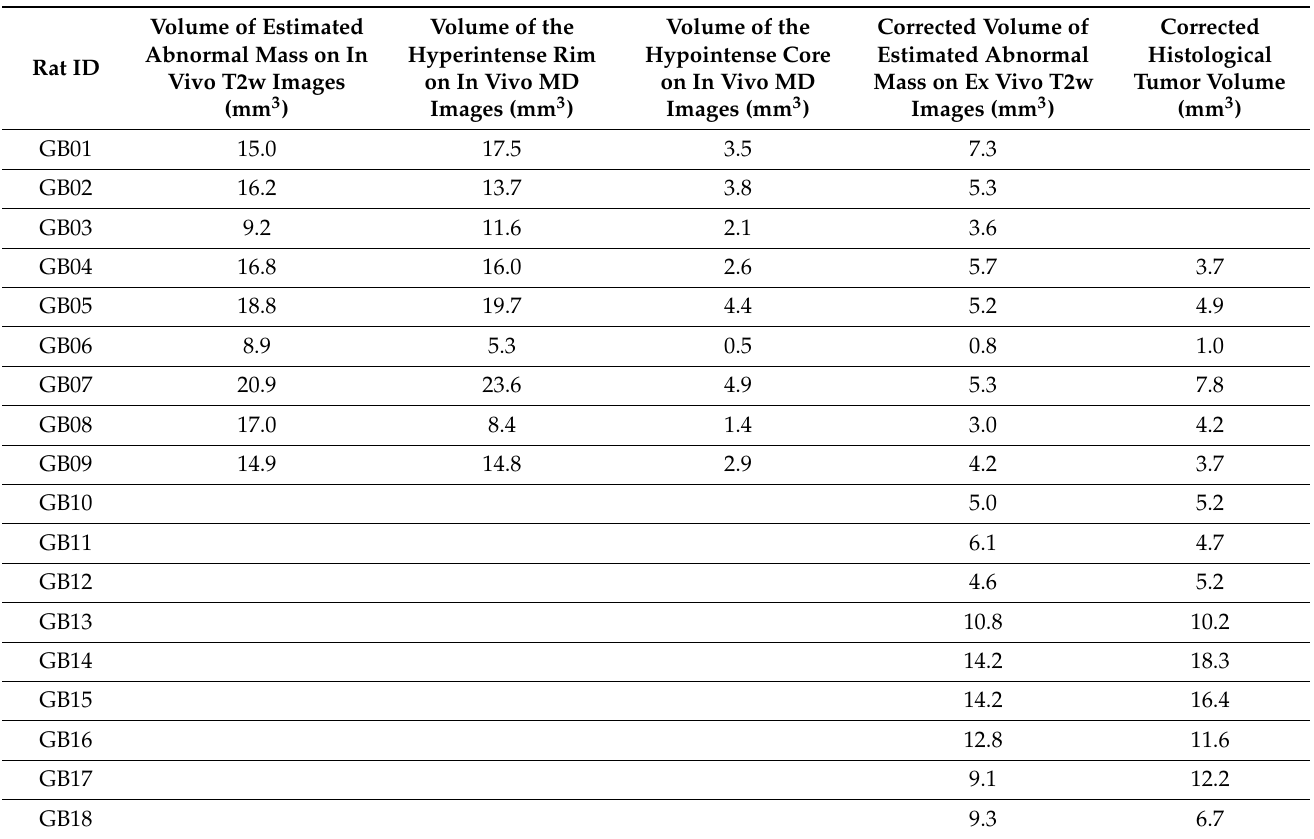
Table 1. Tumor volume estimations from the different modalities. This table summarizes the volumes of the estimated abnormal mass delineated on in vivo and ex vivo MRI, and tumor volumes delineated on cresyl violet-stained histological slices. Corrected volumes are shown of the estimated abnormal mass on ex vivo T2w images and histological tumor volumes for comparison with in vivo MRI. GB023 was not included in the table nor for the analyses, as no tumor could be detected.